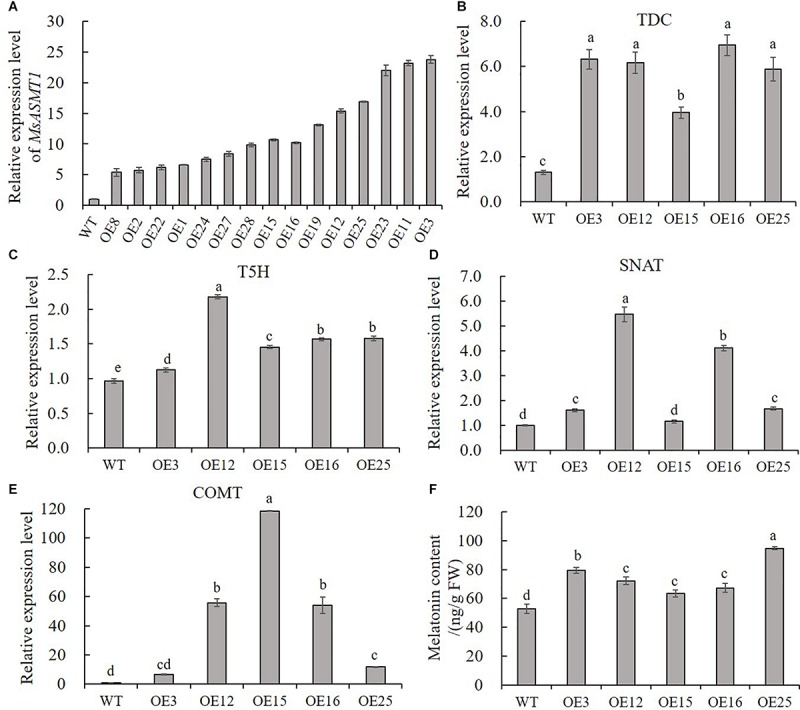
Relative expression level of MsASMT1 and the upstream genes of ASMT in melatonin biosynthesis pathway and the melatonin content in WT plants and OE-MsASMT1 transgenic plants. (A) Relative expression level of MsASMT1 in various transgenic alfalfa plants; (B–E)
MsTDC
(B)
MsT5H
(C)
MsSNAT
(D) and MsCOMT
(E) in WT plants and OE-MsASMT1 transgenic plants; (F) Melatonin content in WT plants and OE-MsASMT1 transgenic plants, the correlation between melatonin content and relative expression level of MsASMT1 is analyzed by SPSS with Pearson Correlation Coefficient (p < 0.05). Data are presented as mean ± SE (n = 3). The letters indicate the differences between WT and OE-MsASMT1 transgenic plants according to ANOVA analysis (p < 0.05).